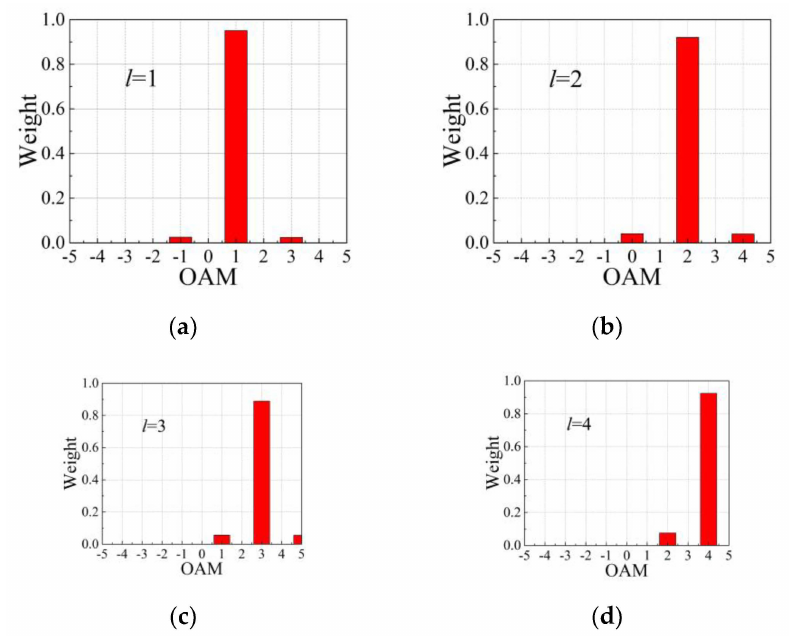
Figure 4. Weights of the OAM modes of the incident beam with different topological charges as sampling the field on the whole measurement plane: panels ( a – d ) are for the topological charges of